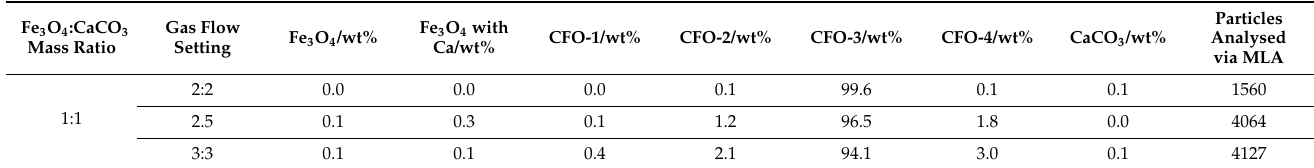
Table 5. Mineral proportion (wt%) of microsphere products as a function of gas flow setting.